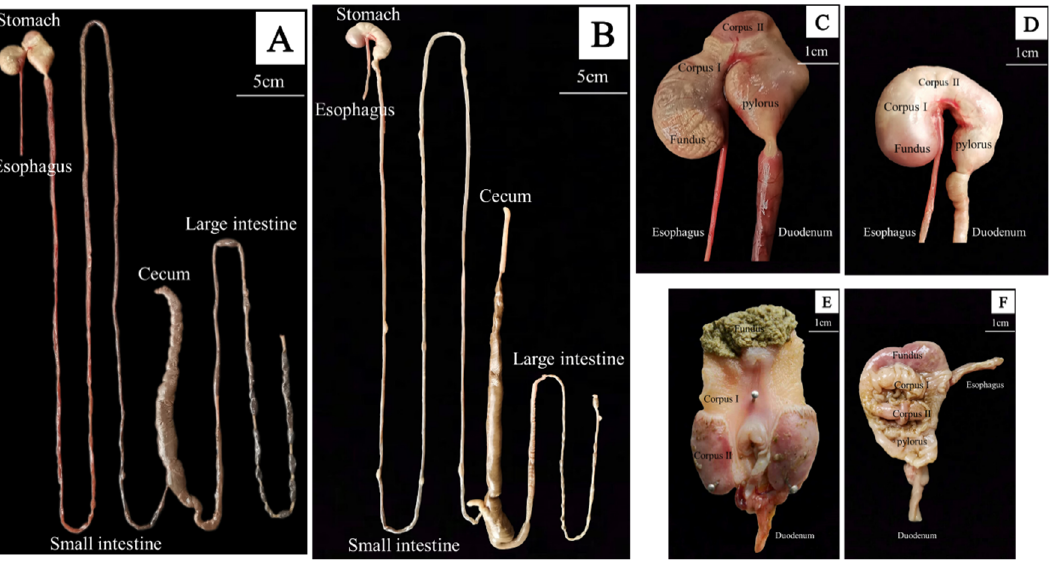
Figure 4. Gross morphological view of the gastrointestinal organs of the plateau zokor and plateau pika. ( A ) Gross morphological view of the GIT of the plateau zokor; ( B ) gross morphological view of the GIT of the Plateau Pika; ( C ) external morphological view of the stomach of the plateau zokor; ( D ) external morphological view of the stomach of the plateau pika; ( E ) internal morphological view of the stomach of the plateau zokor; ( F ) internal morphological view of the stomach of the plateau pika.